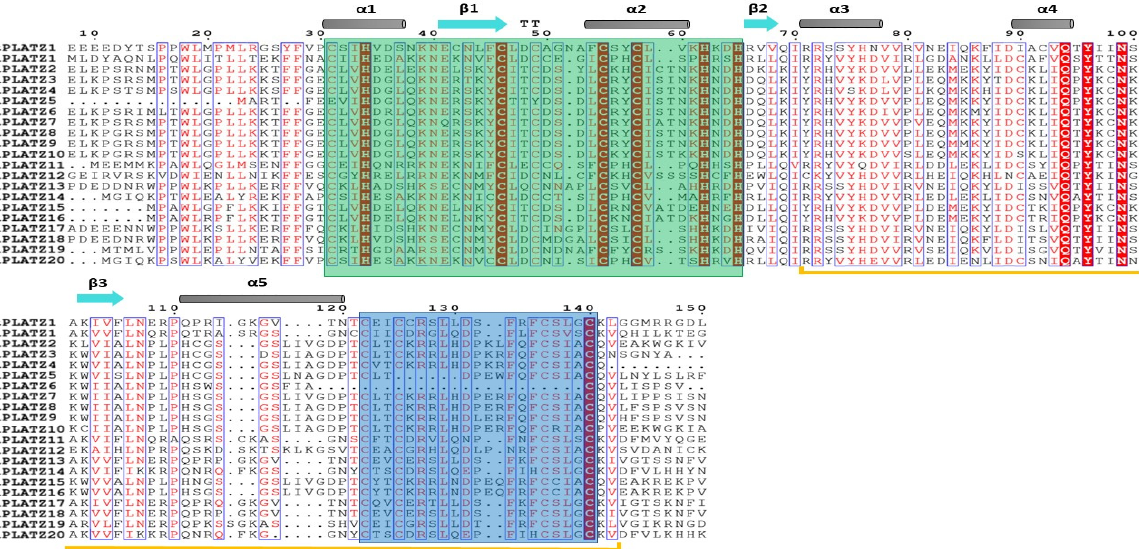
Figure 1. Multiple sequence alignment of all deduced tomato PLATZ polypeptides with that of Arabidopsis. The green box highlights the first conserved region [C-x 2 -H-x 11 -C- x2 -C-x (4–5) -C-x 2 -C-x (3–5) -H-x 2 -H] and the blue box marks the second conserved region [C-x 2 -C-x (10–12) -C-x 3 -C], which are essential for zinc-dependent DNA binding. The yellow underline indicates the location of the PLATZ domain. The elements of the secondary structure determined using the ESPript 3.0 web server are represented by gray bars ( α -helices) and blue-green arrows ( β -strands) above the alignment.